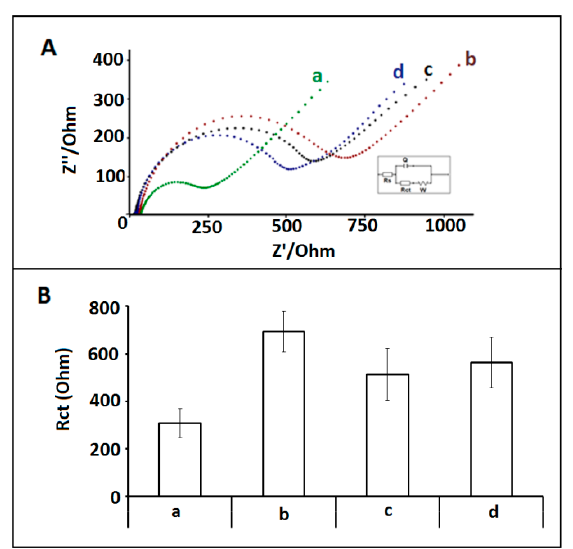
Figure 6. ( A ) Nyquist diagrams representing the R ct values obtained by ( a ) 1µg/mL miRNA-34a probe modified /IL/CA/PGE, hybridization between 1 µg/mL miRNA-34a DNA probe and 10 µg/mL, ( b ) miRNA-34a target, ( c ) miRNA-181b, ( d ) miRNA-155. ( B ) Histograms representing the R ct values obtained by ( a ) 1µg/mL miRNA-34a probe modified /IL/CA/PGE, hybridization between 1 µg/mL miRNA-34a DNA probe and 10 µg/mL, ( b ) miRNA-34a target, ( c ) miRNA-181b, (d) miRNA-155.